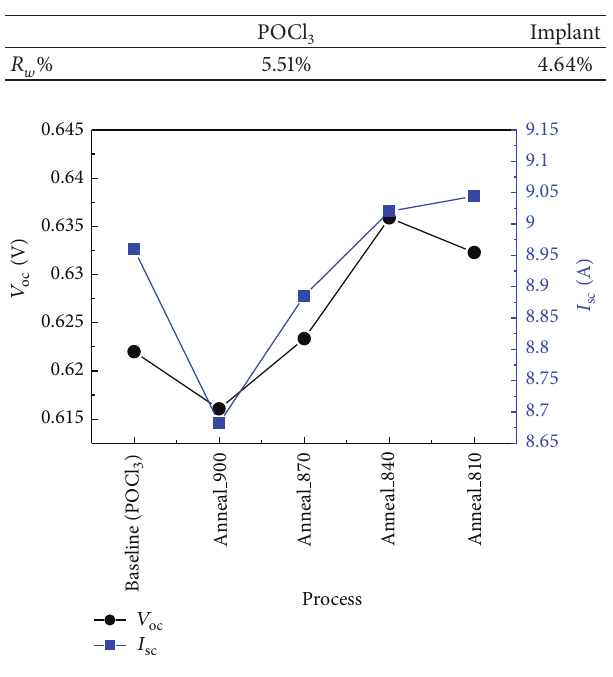
Figure 7: 𝑉 processes.